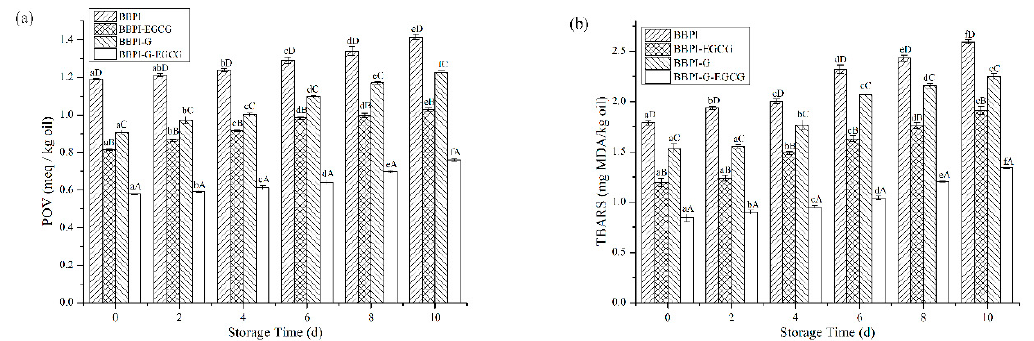
Figure 5. The POV ( a ) and TBARS ( b ) of the BBPI, BBPI-EGCG, BBPI-G, and BBPI-G-EGCG prepared oil-in-water emulsions stored at 25 ◦ C 10 days. a–f means with di ff erent letters di ff er significantly in the same emulsion with di ff erent days ( p < 0.05). A–D means with di ff erent letters di ff er significantly in the same day with di ff erent emulsions ( p <